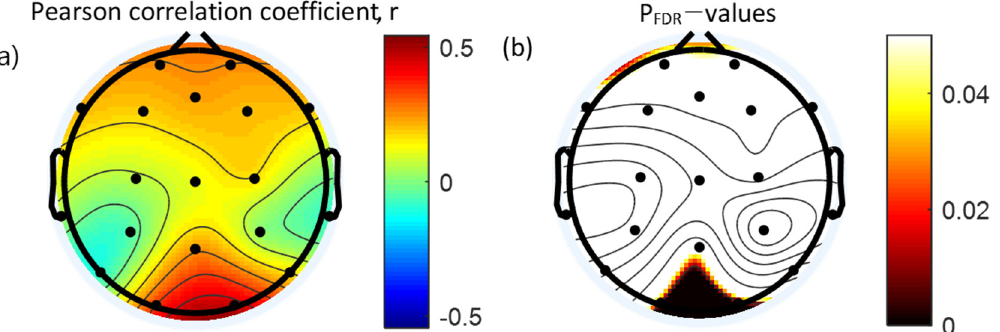
Figure 5. Topographical representation of the statistical results of the Pearson’s correlation analysis between the absolute gamma power and Wender Utah Rating Scale. ( a ) Pearson’s correlation coefficients. ( b ) Topographical distribution of the corresponding False Discovery Rate corrected p -value. FDR: False Discovery Rate. Table 6. Linear regression models of WURS as predicted by the absolute gamma power during the VWM task over the occipital scalp sites in healthy volunteers.